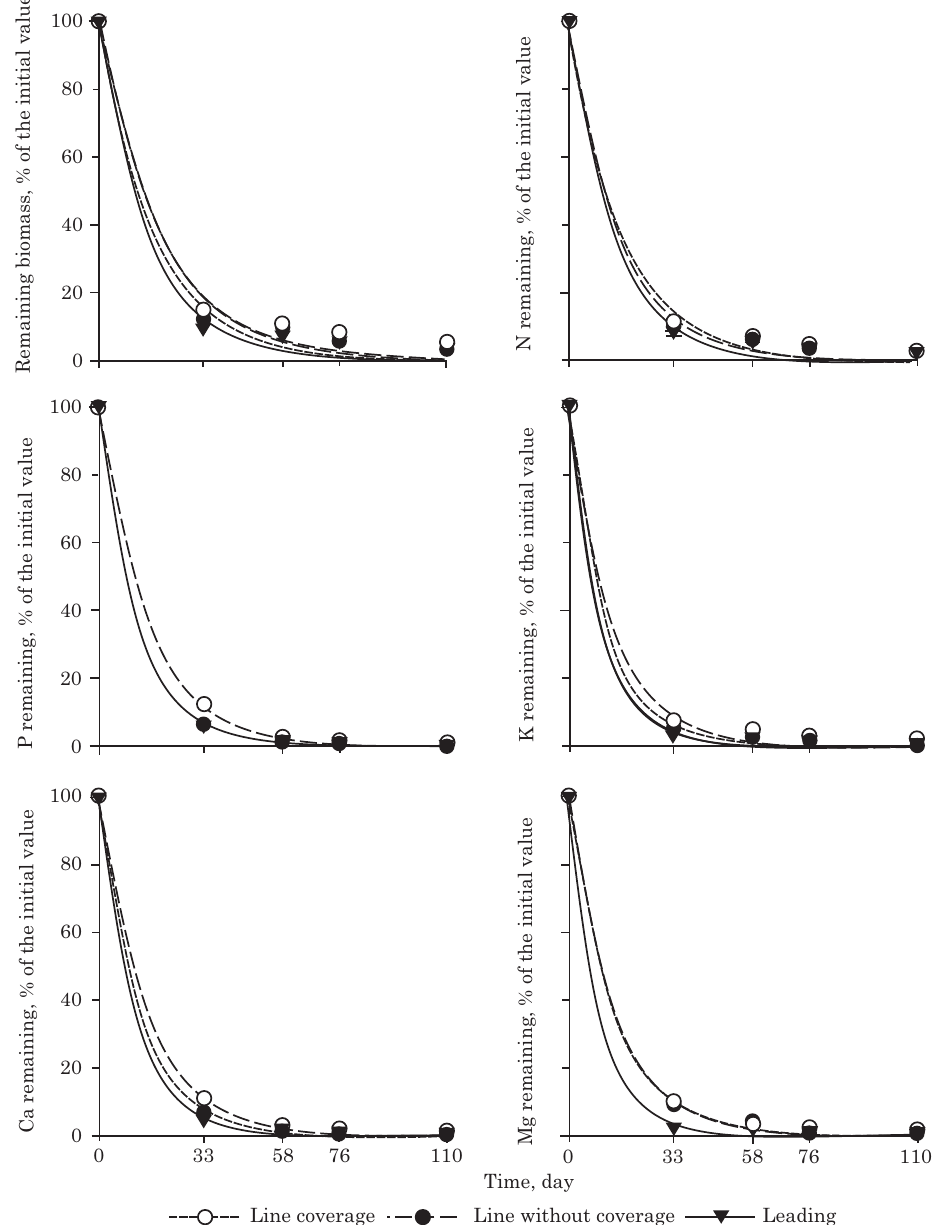
Figure 2. Remaining biomass, and N, P, K, Ca, and Mg remaining from hairy vetch in decomposition in the vine plant row without plastic shelter (VPRWS), in the vine plant row with plastic shelter (VPRS), and in the between-row area (BR). Values expressed as % of initial values. Vertical bars represent standard errors. The equations and significance of the adjustments are shown in table